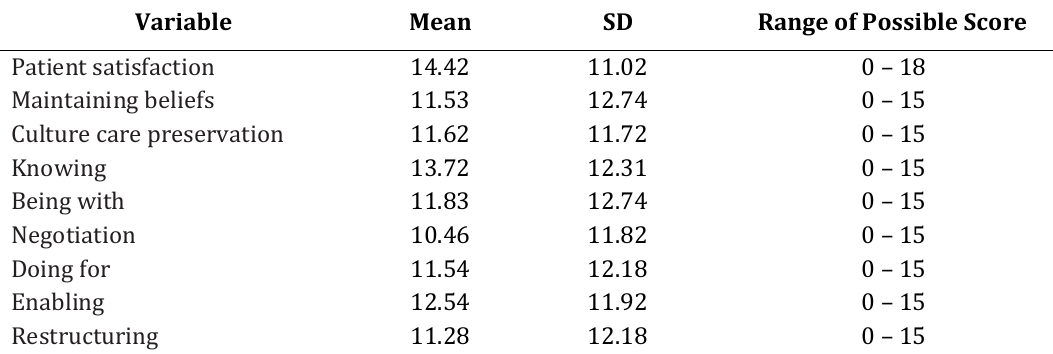
Distribution of the Mean Value of All Variables Variable Patient